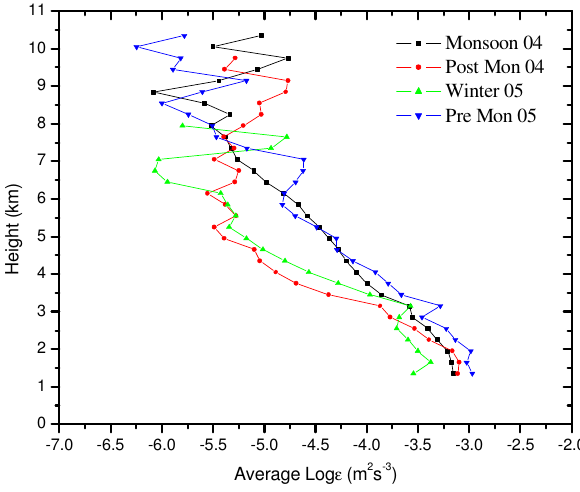
Fig. 13. Height profile of mean energy dissipation rates during dif- Figure 13 ferent seasons,